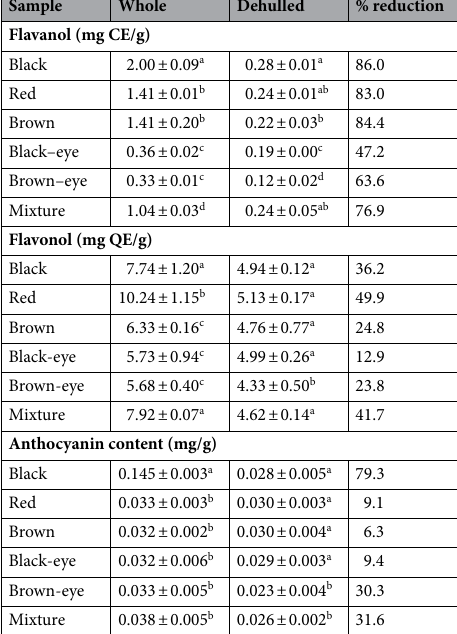
Table 1. Flavanol, flavonol and anthocyanin content of dehulled and whole Bambara groundnut. Values represent the mean ± standard deviation of triplicate readings (n = 3). Values with different superscript in same column are significantly different (p <